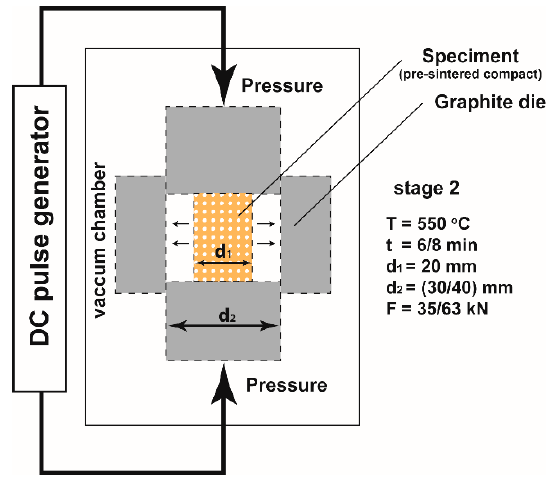
Figure 4. SPT processing scheme.